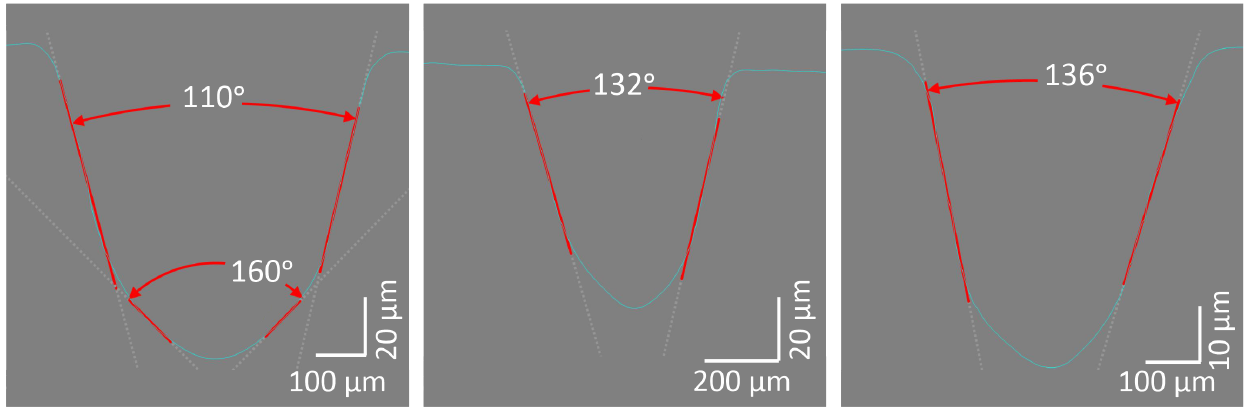
Figure 8. Effect of air assistance—significant non-uniformities in groove profile ( a – c are sectional lines).